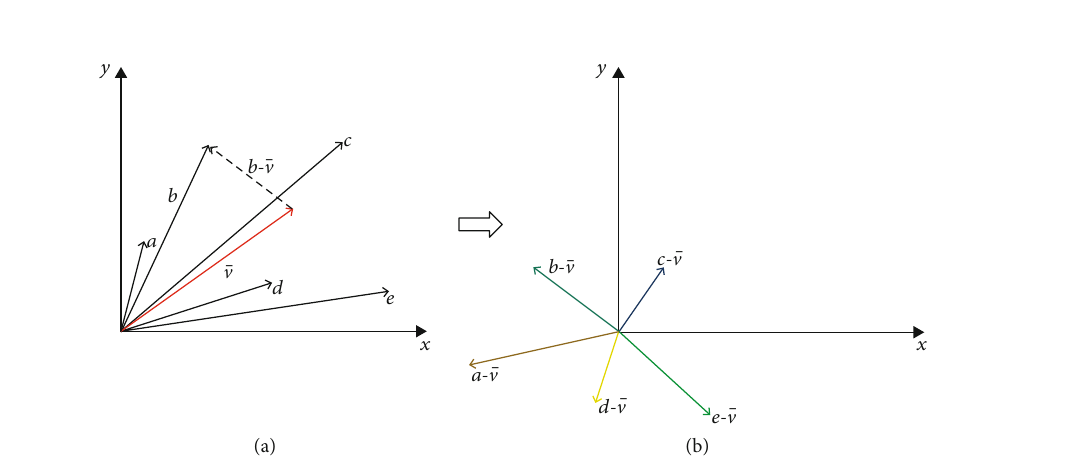
Figure 4: (a) One way of emphasizing the distinctive features of a set of vectors a , b , c , d consists in subtracting their average vector (as in the case of vector b ). (b) In this way, vectors become more separated (in terms of the angle between